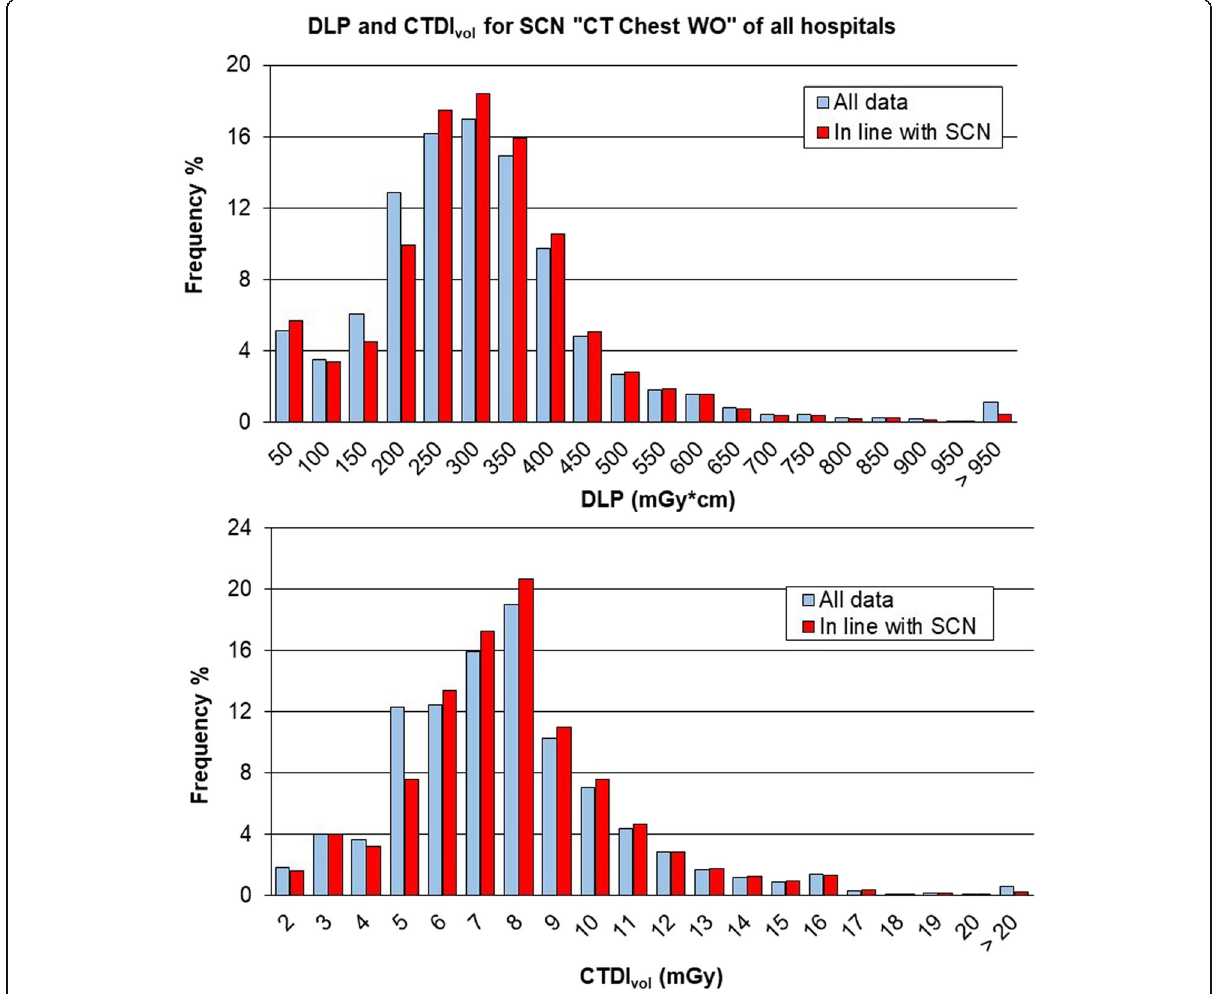
Fig. 8 Comparison between distributions of total dose-length product (DLP) and volumetric computed tomography dose index (CTDI vol ) of the whole data and those in line with the study common name (SCN) “ CT Chest WO ” , i.e ., studies with all series belonging to that